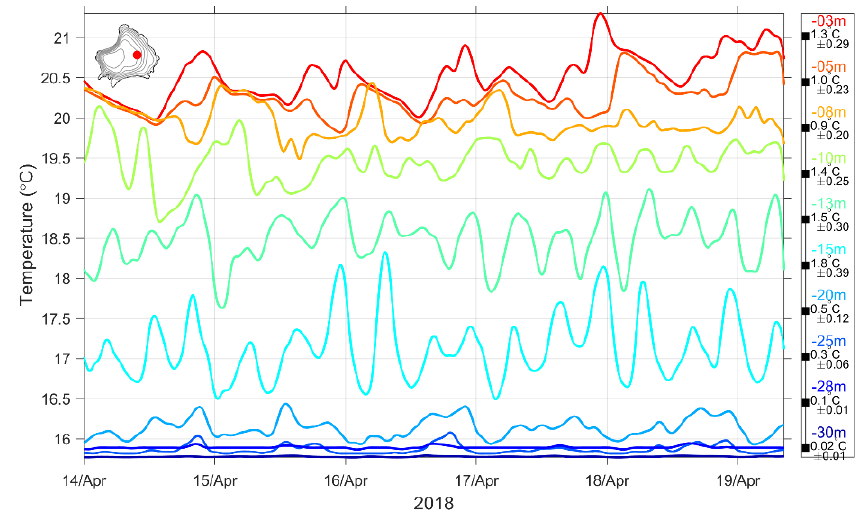
Figure 5. Thermistor chain time series for the field campaign from 14–20 April. The colored lines correspond to the thermistor depths. In the right side, every thermistor is shown in color-coded manner: the position in meters (first number), amplitude range in °C (second number), and standard deviation in °C (third number). Inset map shows the location of the thermistor chain in the lake.